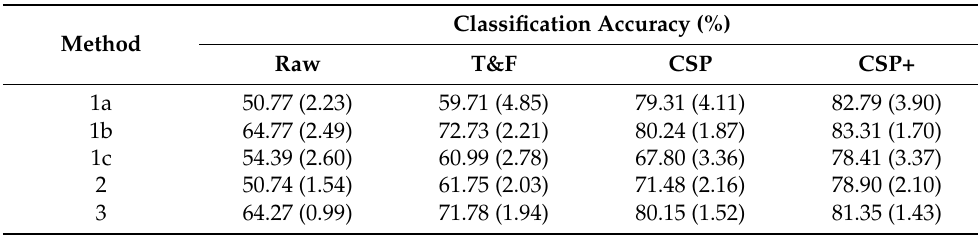
Table 5. The mean (standard error) classification accuracy from each feature set for each method when using SVM